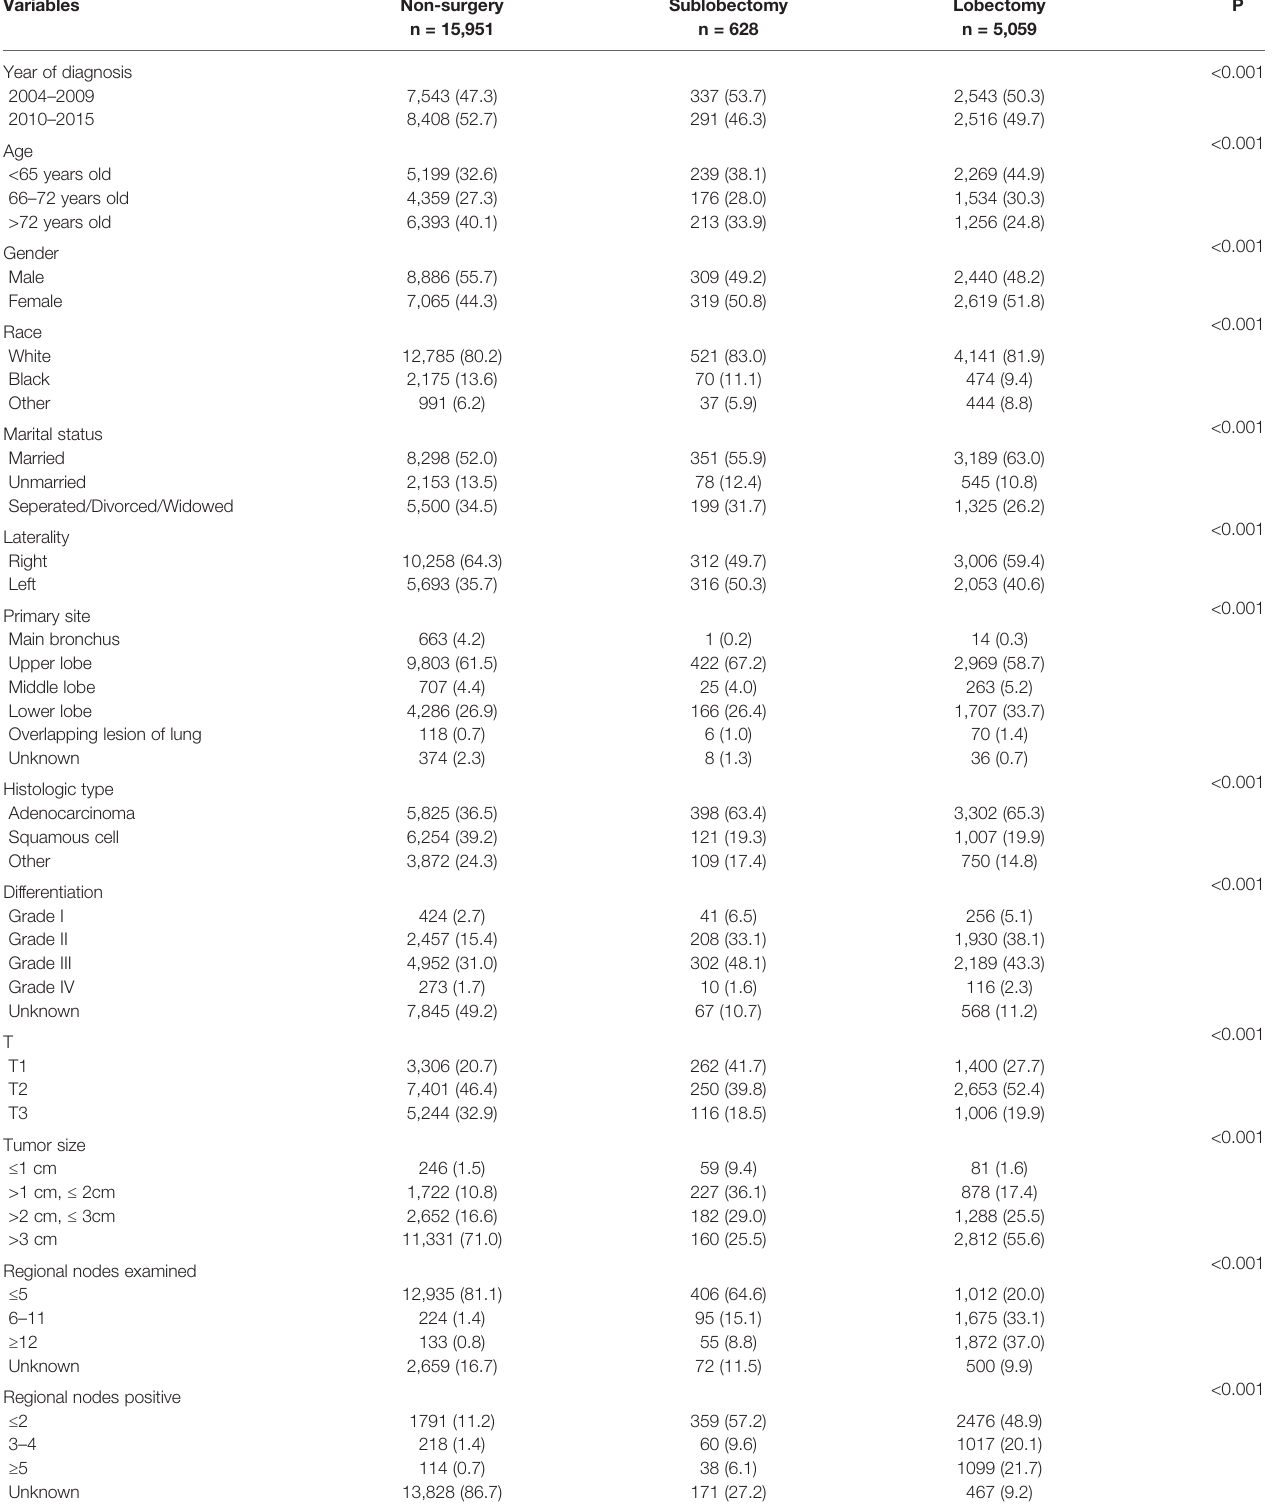
TABLE 1 | Baseline characteristics of IIIAN2 stage NSCLC